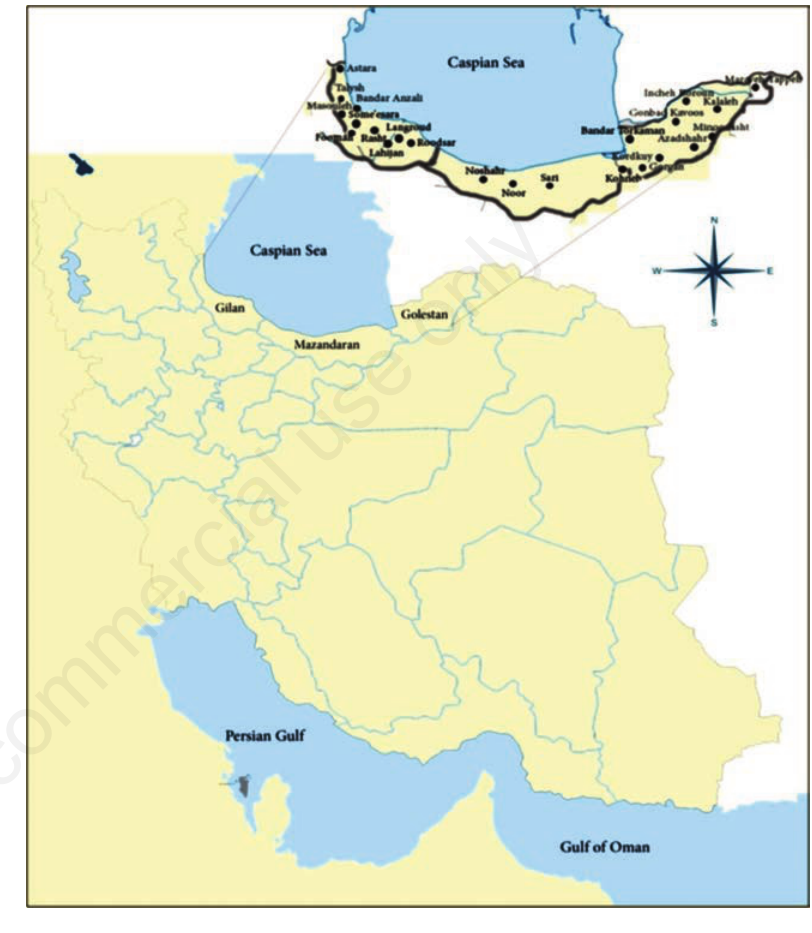
Figure 1. Map of study area in the three provinces of Mazandaran, Gilan and Golestan, northern Table 1. The genus and number of the rodents in three northern provinces of Iran. Rodent species